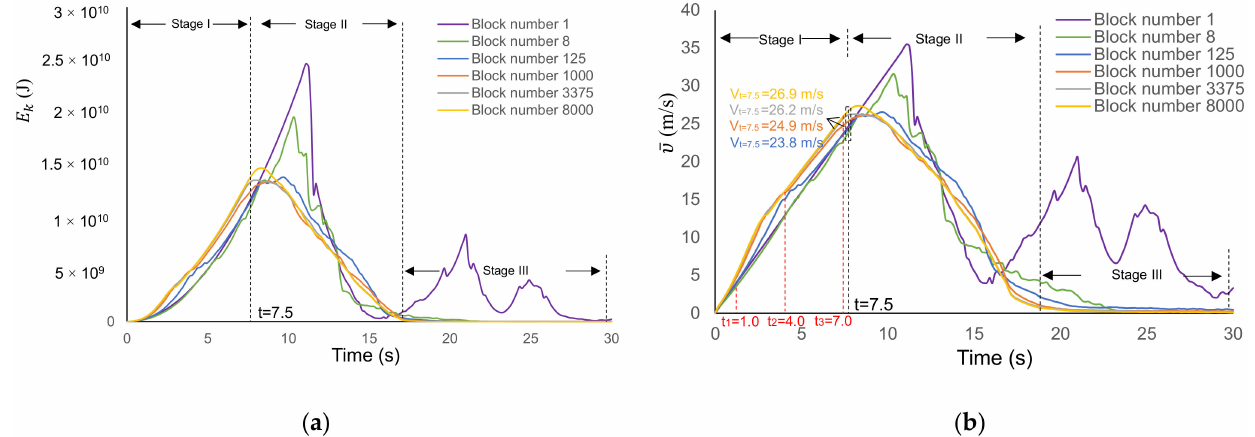
Figure 10. ( a ) Total kinetic energy of the computation domain, and ( b ) the overall feature speed over time. t 1 , t 2 and t 3 represent the time when the number of blocks equal to 125, 1000, and 3375 begin to show an obvious difference in movement speed, in relation to the higher breakage degree of the sliding mass.